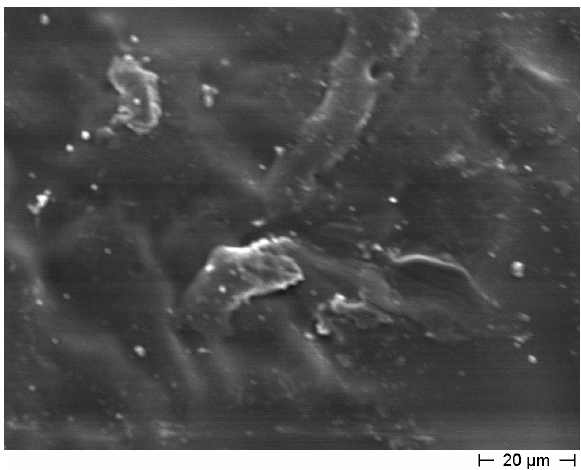
Figure 7. FE-SEM micrograph of the exterior wall of the cementitious small hollow tube (recipe for maccherone No. 5) coated with polyester resin. The polymeric layer is homogeneous, free from cracks and completely covers the cement